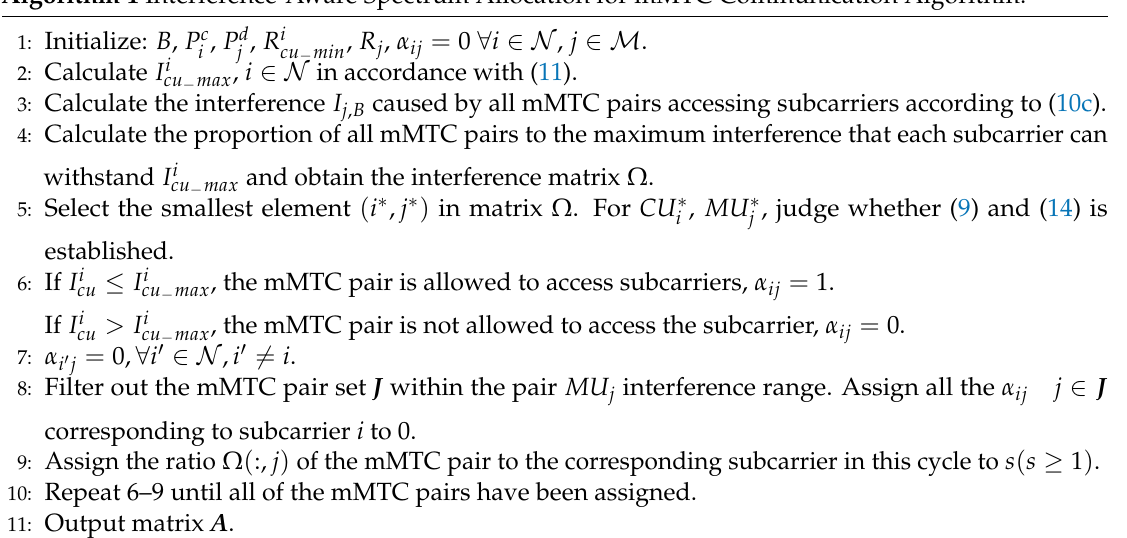
Algorithm 1 Interference-Aware Spectrum Allocation for mMTC Communication